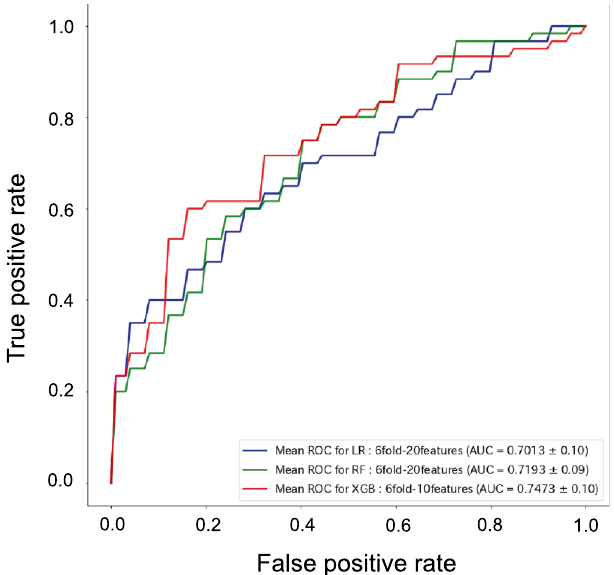
Figure 2. ROC curves for predicting relapse in RA patients. ROC curves of Logistic Regression, Random Forest, and XGBoost for predicting relapse in RA patients are shown. ROC receiver operating characteristics, RA rheumatoid arthritis.